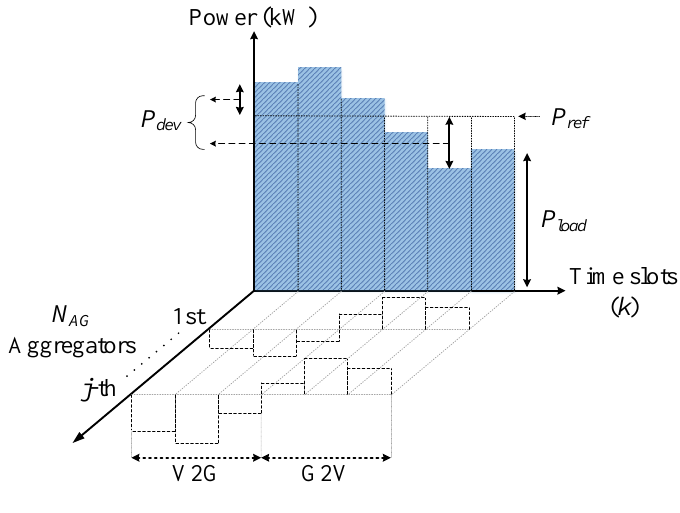
Figure 4. 3D power allocation